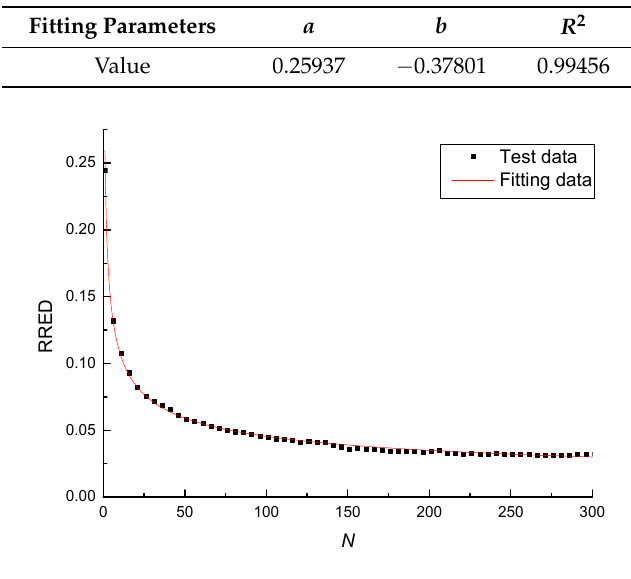
Figure 6. Test data and fitting data.